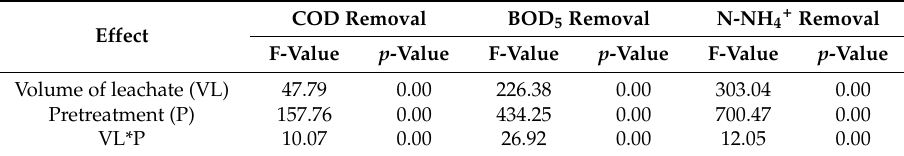
Table 8. Results of factorial ANOVA for the removal efficiencies of COD, BOD 5 and ammonium nitrogen (*—interaction between